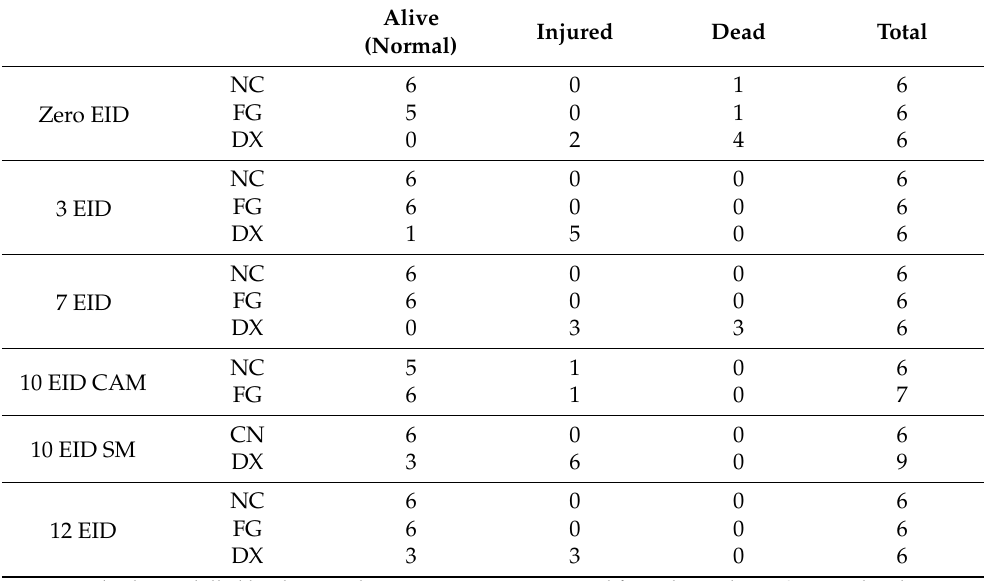
Table 4. Evaluation of CE’s viability, lesions and embryonic mortality when treated with FG and DX at different ages.